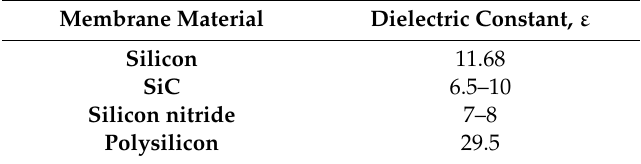
Table 2. Most common CMUT membrane materials and their dielectric